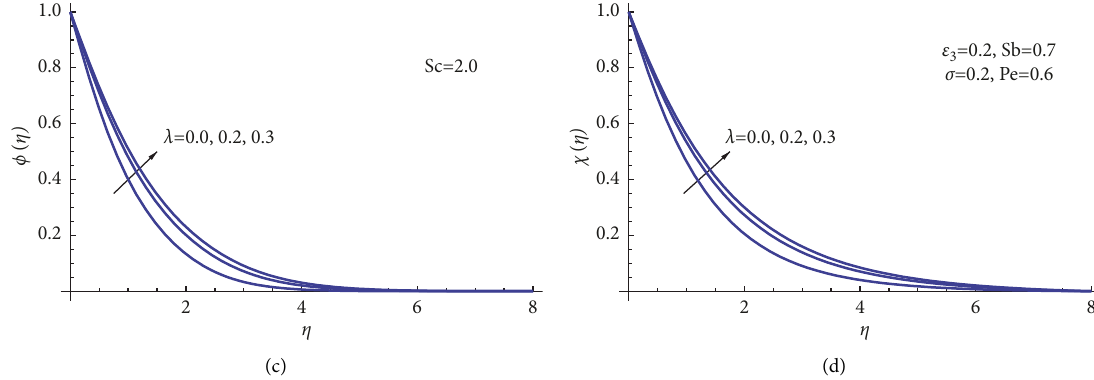
Figure 3: (a) Impact of λ on f ′ ( η ) . (b) Impact of λ on θ ( η ) . (c) Impact of λ on ϕ ( η ) . (d) Impact of λ on χ ( η ) .